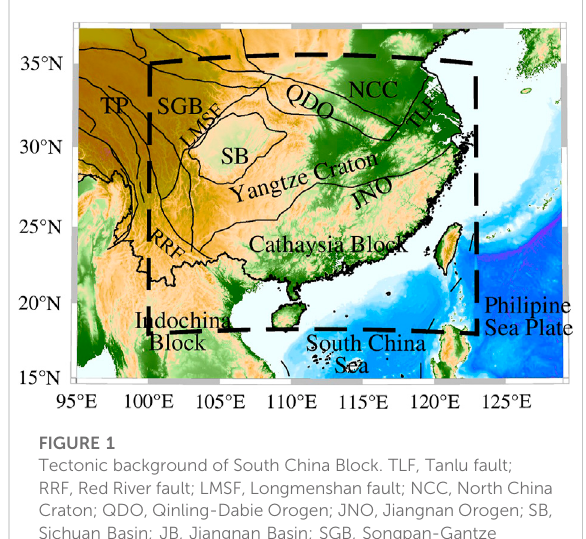
FIGURE 2 (A) Distribution of permanent and portable seismic stations (blue triangles) in the South China Block (B) Insert map: Con fi guration of seismic stations and seismic events with Ms > 5.5 for the year 2016, to illustrate the potential ray path